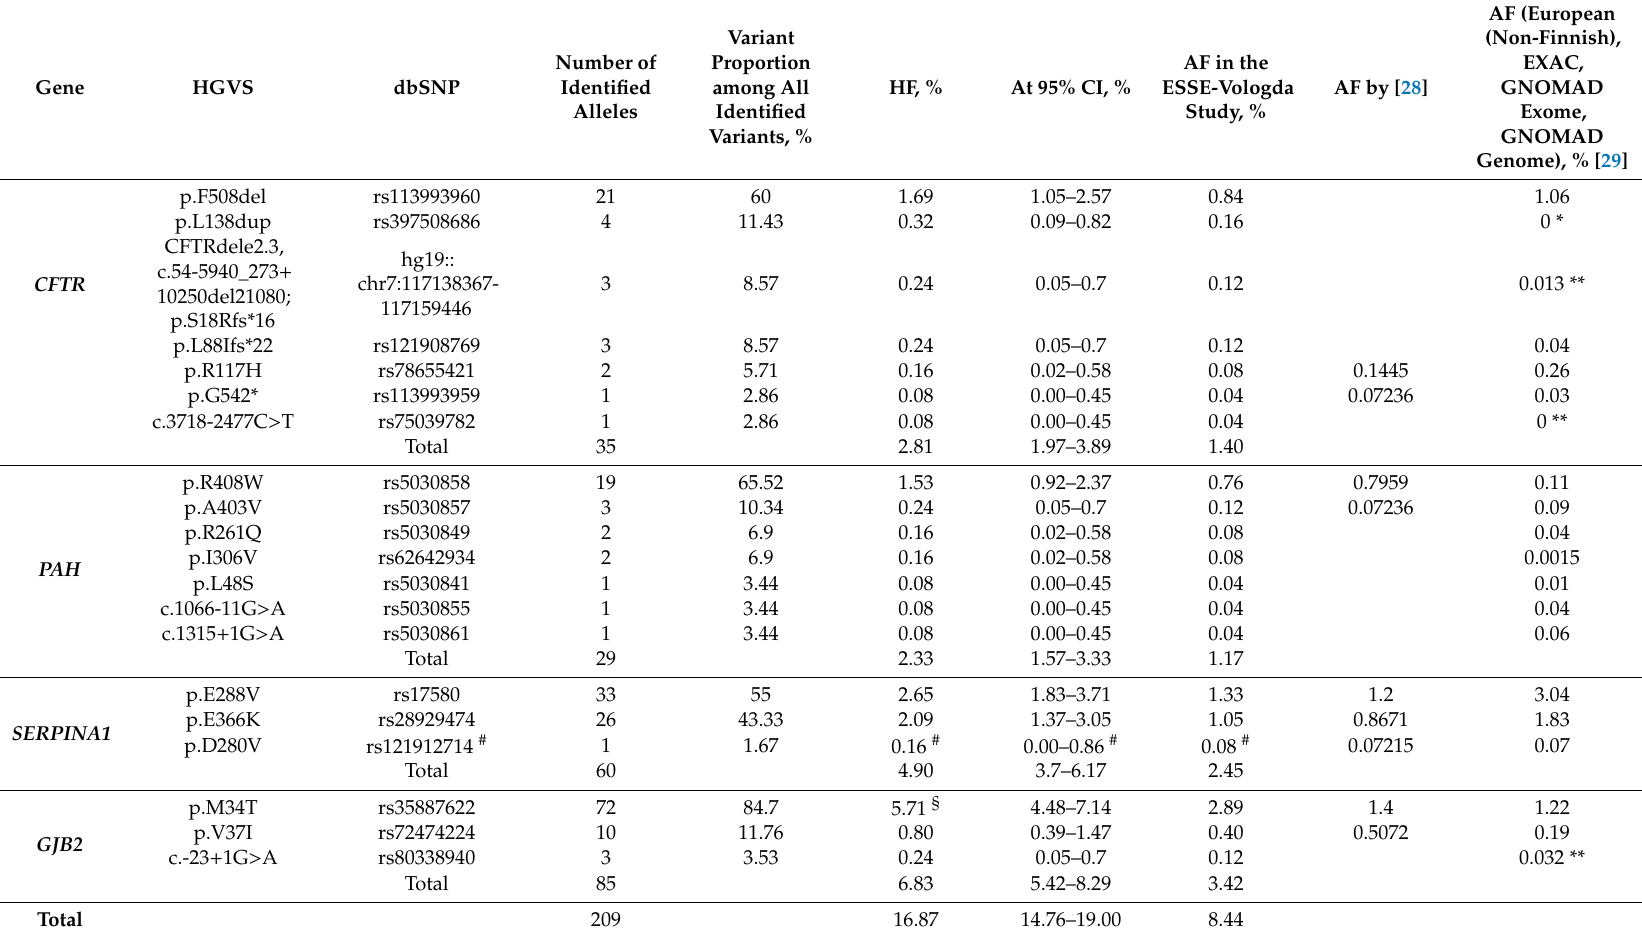
Table 1. Identified variants in the CFTR, PAH, SERPINA1 , and GJB2 genes among 1244 participants of the ESSE-Vologda